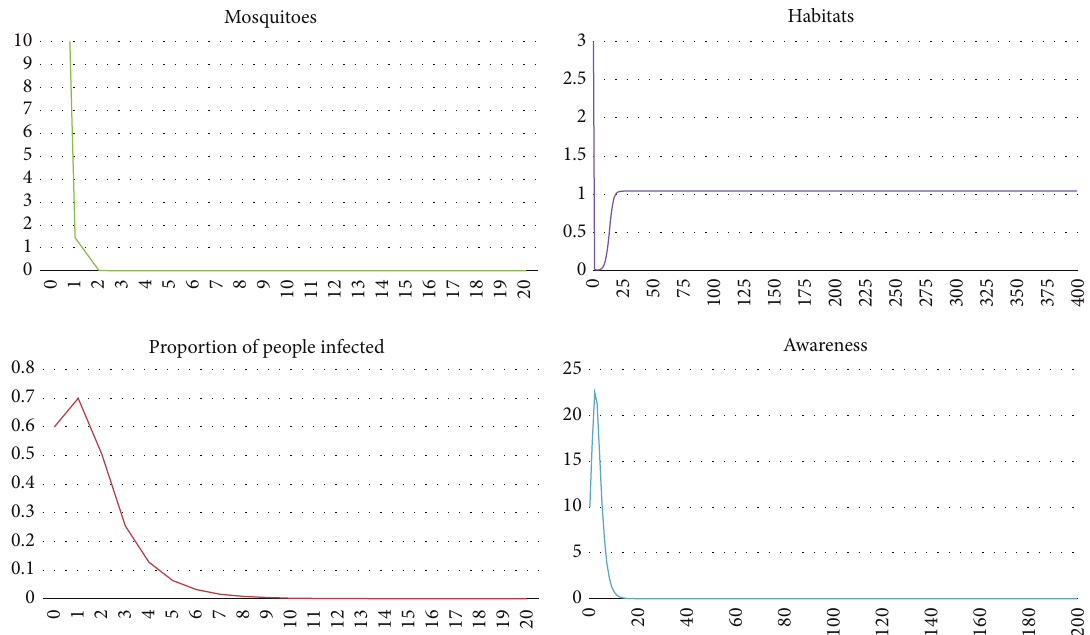
Figure 1: The above graph is generated with parameter values 𝑎 = 0.5 , 𝑝 = 5 , 𝑏 = 0.48 , 𝑐 = 0.04 , 𝑙 = 0.5 , 𝑖 = 0.5 , 𝑟 = 0.5 , and 𝑓 = 20 (the parameters are placed in the region where 𝑏 = (1 − 𝑐)(1 − 𝑙) ). One can see that the solutions converge to the degenerate equilibrium point.